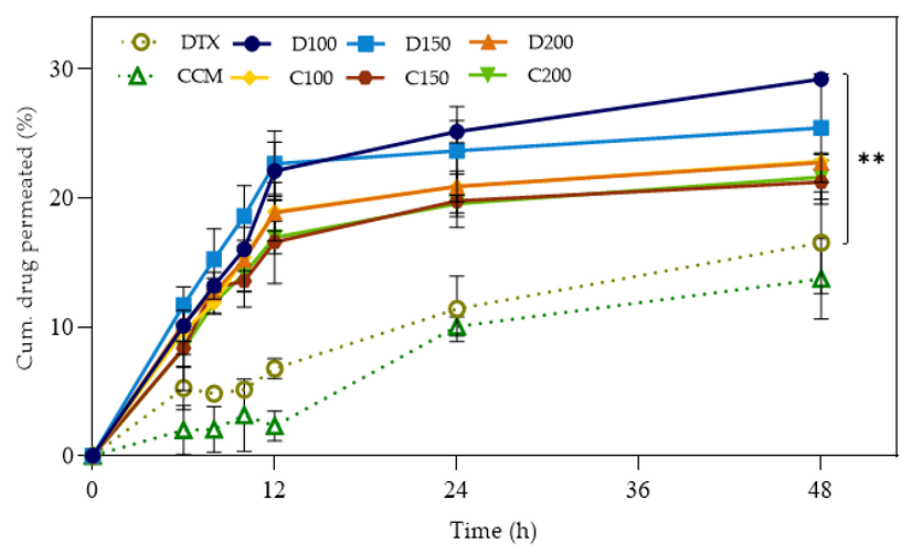
Figure 6. Drug release profiles of DTX- and CCM-loaded nanoemulsions using Franz-diffusion cell apparatus in simulated lung fluid (SLF) solution at pH 7.4. The analysis was carried out at 37 ± 1 °C for up to 48 h. Error bars denote standard deviation ( n = 2) and asterisks denote statistically significant differences between groups (** p < 0.01). Cum: Cumulative; h: Hour; DTX/D: Docetaxel; CCM/C: Curcumin.